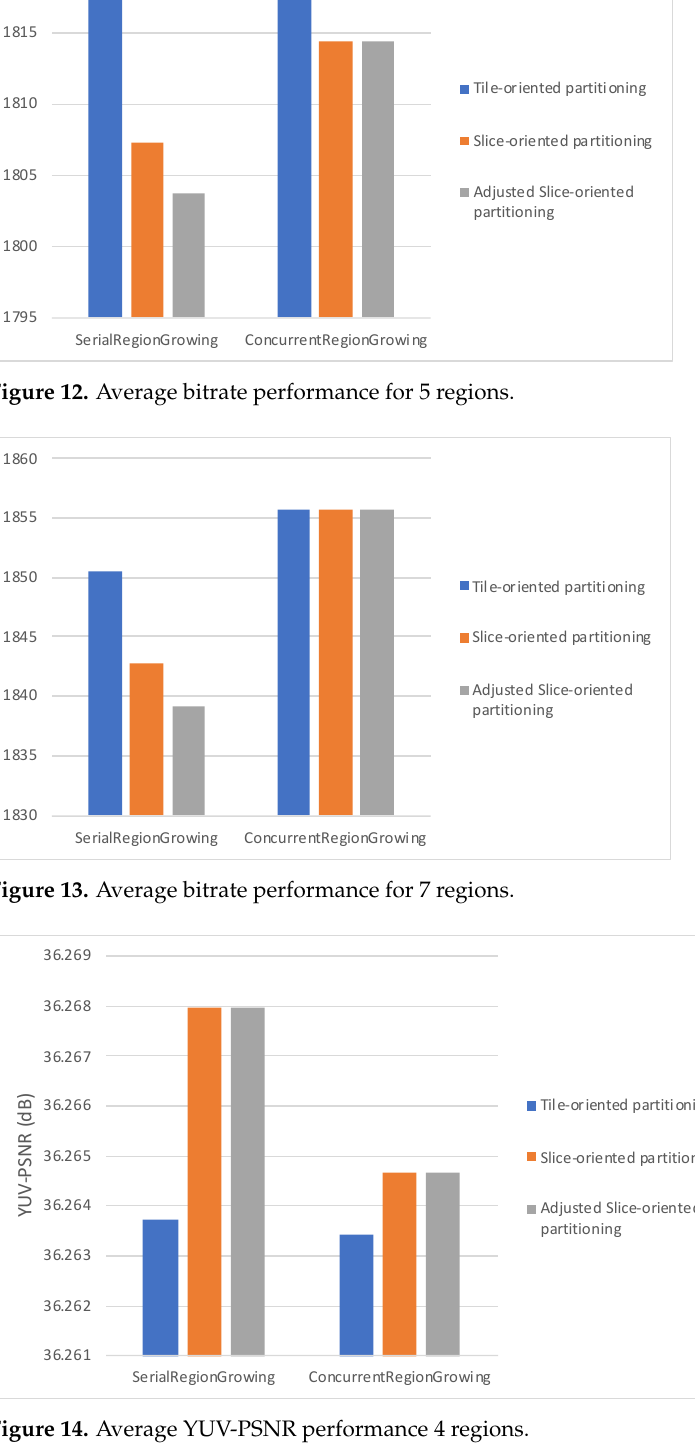
Figure 14. Average YUV-PSNR performance 4